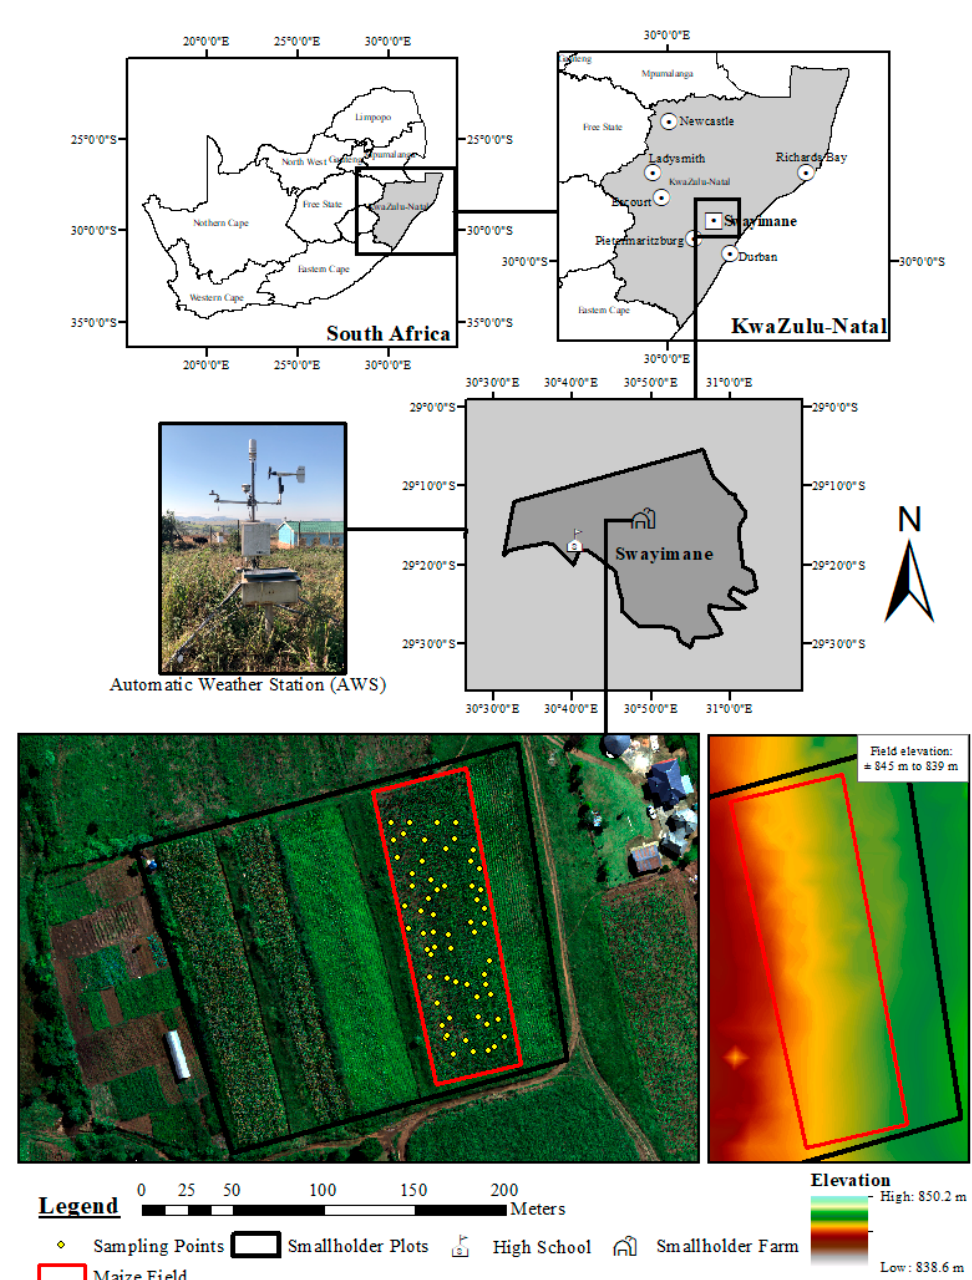
Figure 2. Location of the Swayimani study area, study site, and smallholder maize